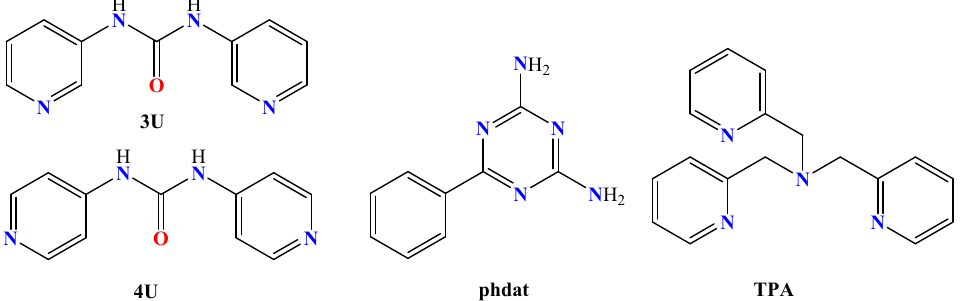
Figure 8. The syntax formula of the co-ligands: 3U = 1,3–dipyridin–3–ylurea; 4U = 1,3–dipyridin–4– ylurea; phdat = 2,4–diamine–6–phenyl–1,3,5–triazine and TPA = tris(2–pyridyl)amine.